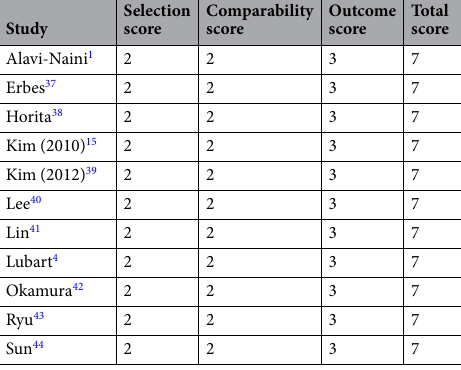
Table 2. Newcastle-Ottawa scoring system for cohort